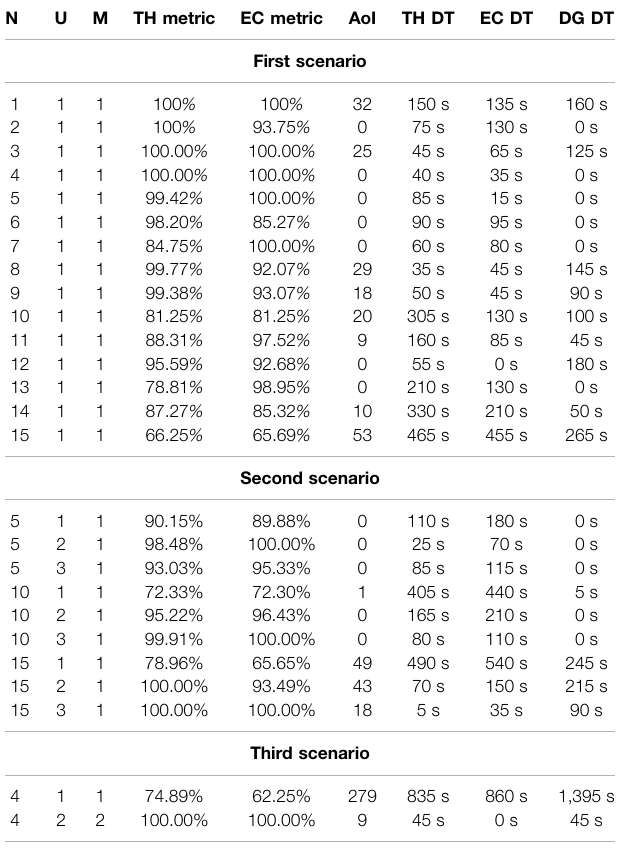
TABLE 2 | Results for the three considered scenarios.